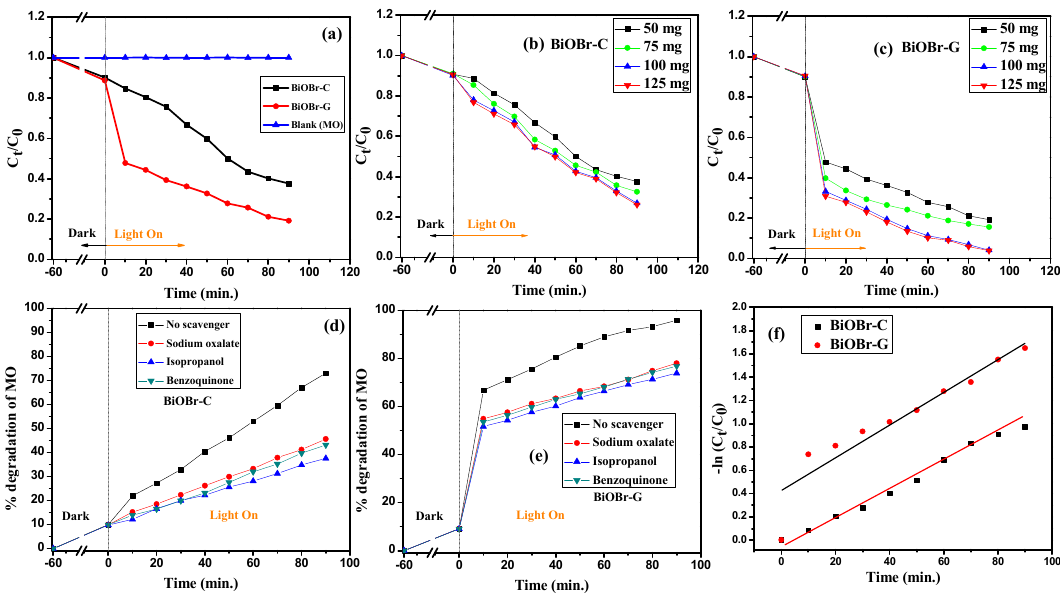
Figure 6. Photodegradation efficiency of MO by BiOBr ‐ C and BiOBr ‐ G ( a ) with time, ( b ) with different concentrations of BiOBr ‐ C, ( c ) with different concentrations of BiOBr ‐ G, ( d ) Effects of scavengers on MO degradation using BiOBr ‐ C, ( e ) Effects of scavengers on MO degradation using BiOBr ‐ G, and ( f ) Kinetic linear simulation curves of MO over the samples. Through the control experiment, it was found that there was no degradation of methyl orange using the leaf extract alone, which suggests that the plant extract alone does not possess any photocatalytic activity (Supporting Information, Section S6).